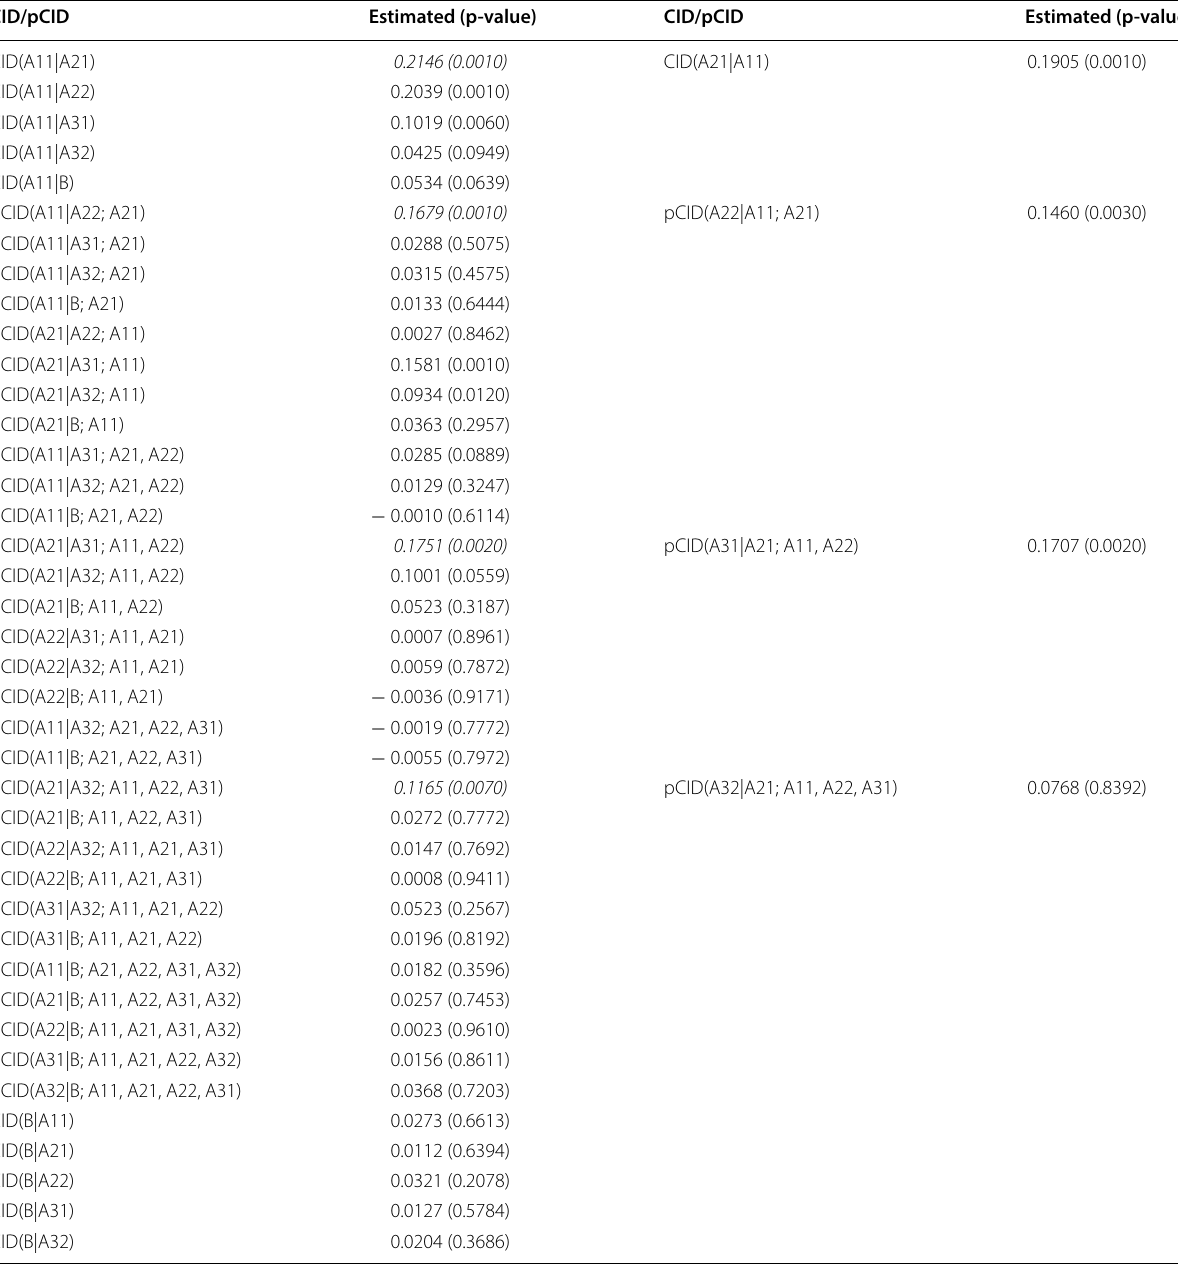
Table 2 The estimated CID and pCID values in one simulation of sample size n